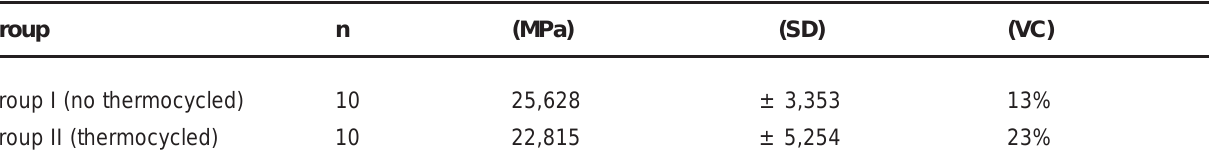
TABLE 1- Number of samples per group (n), mean tensile strength (Mpa), standard deviation (SD) and variation coefficient values for the microtensile bond strength test of In-Ceram and Panavia F